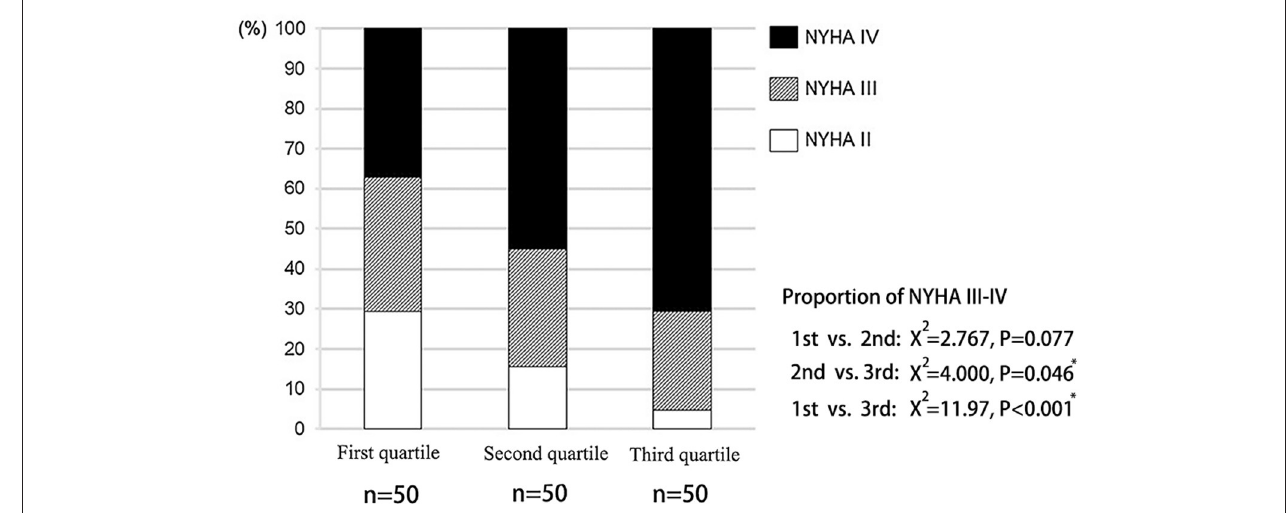
FIGURE 2 | Distribution of cardiac function in patients with different liver hardness